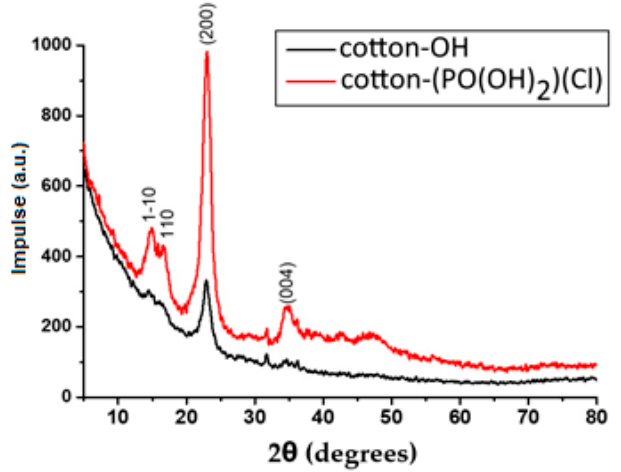
Figure 3. XRD spectra of cotton-OH and cotton-(PO(OH) 2 )(Cl).